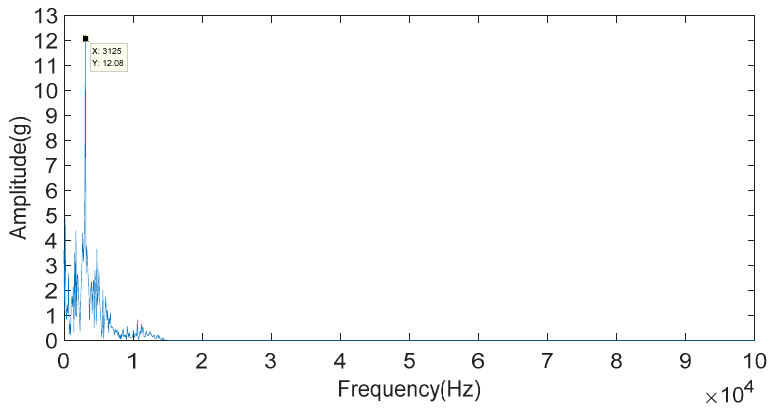
Figure 22. Frequency characteristics of reconstructed signals of node S (3,0).